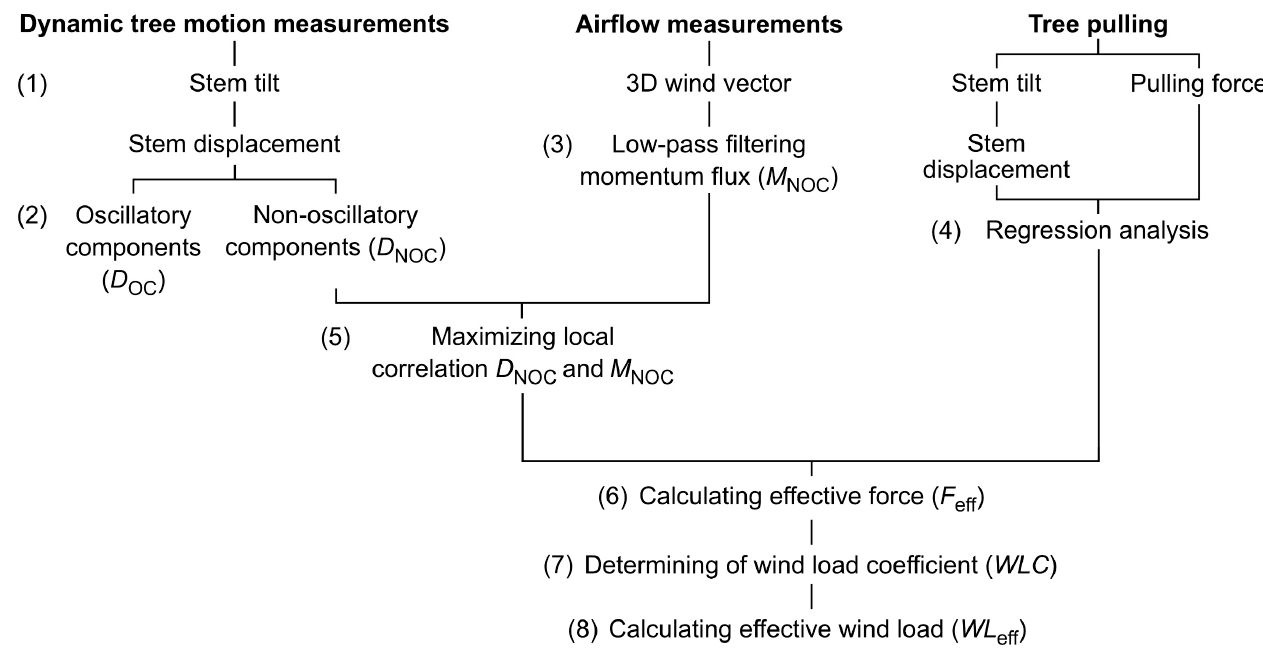
Figure 1. Main steps in the calculation of the effective wind load ( WL eff